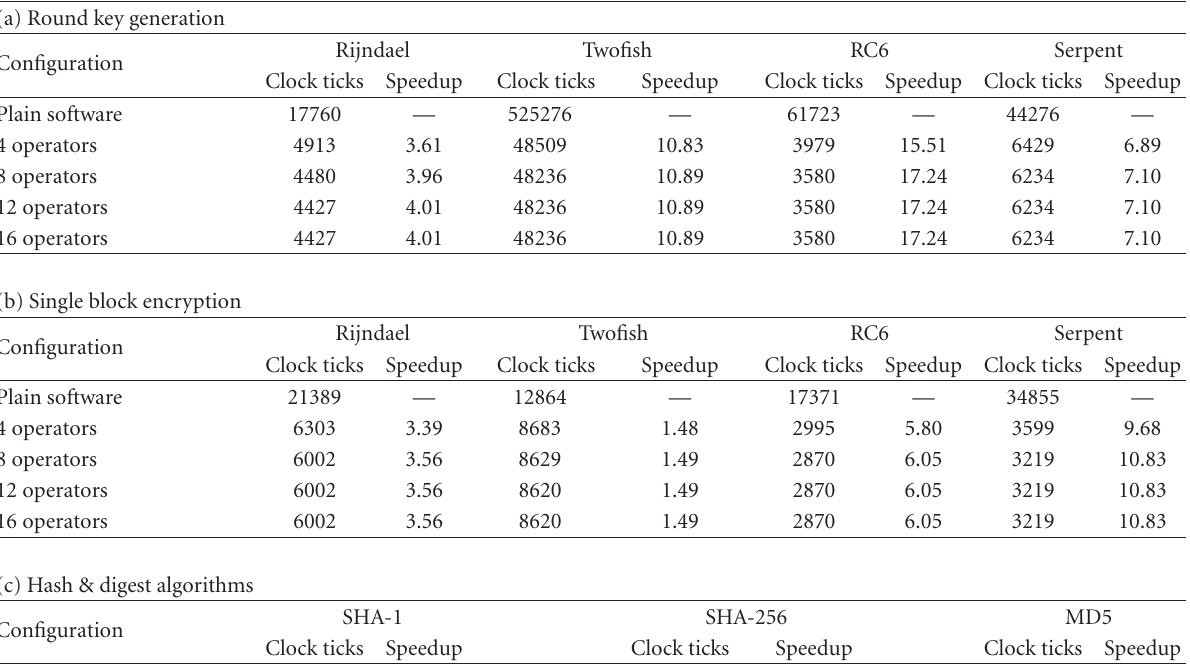
Table 6: Influence of a specialized operator set with 1 multiplication and 1 division operator on benchmark